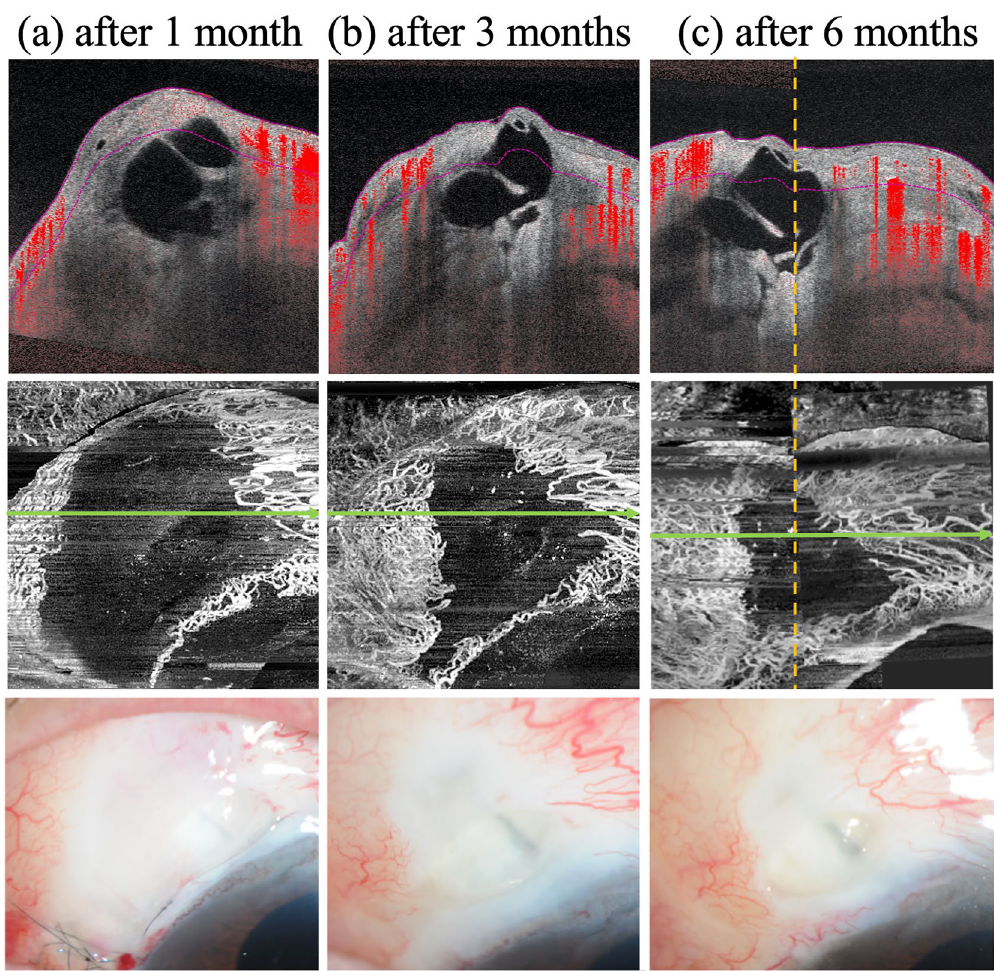
Figure 2. A typical case in which the complete avascular area (CAA) is reduced over time. Cross-sectional OCTA images overlying the B-scan images (upper), AS-OCTA en face images (middle), and slit-lamp microscopy photographs (bottom) at 1 ( a ), 3 ( b ), and 6 ( c ) months postoperatively. CAAs detected in the AS-OCTA are identical to the avascular area observed in the slit-lamp microscopy. The CAA decreases in size